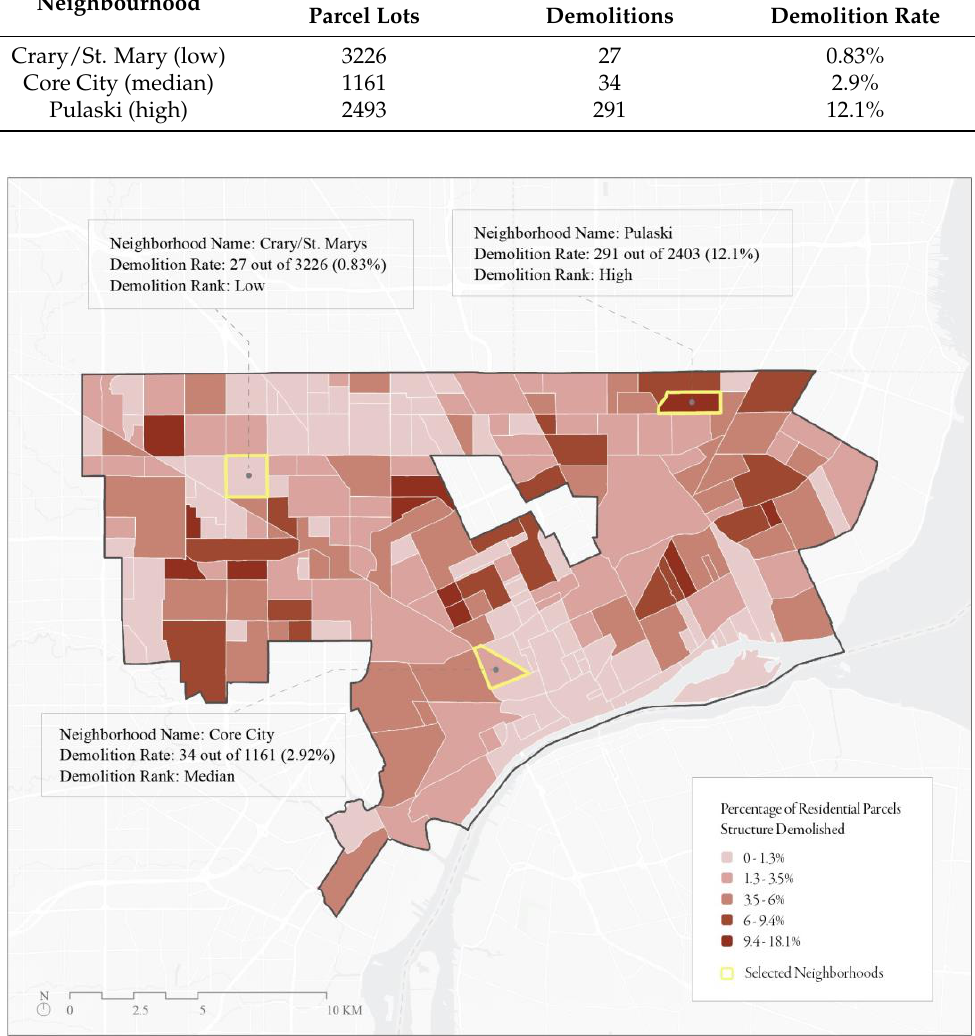
Figure 6. Residential demolition rates by neighbourhood, and three areas of interest, 2014–2018 NAIP